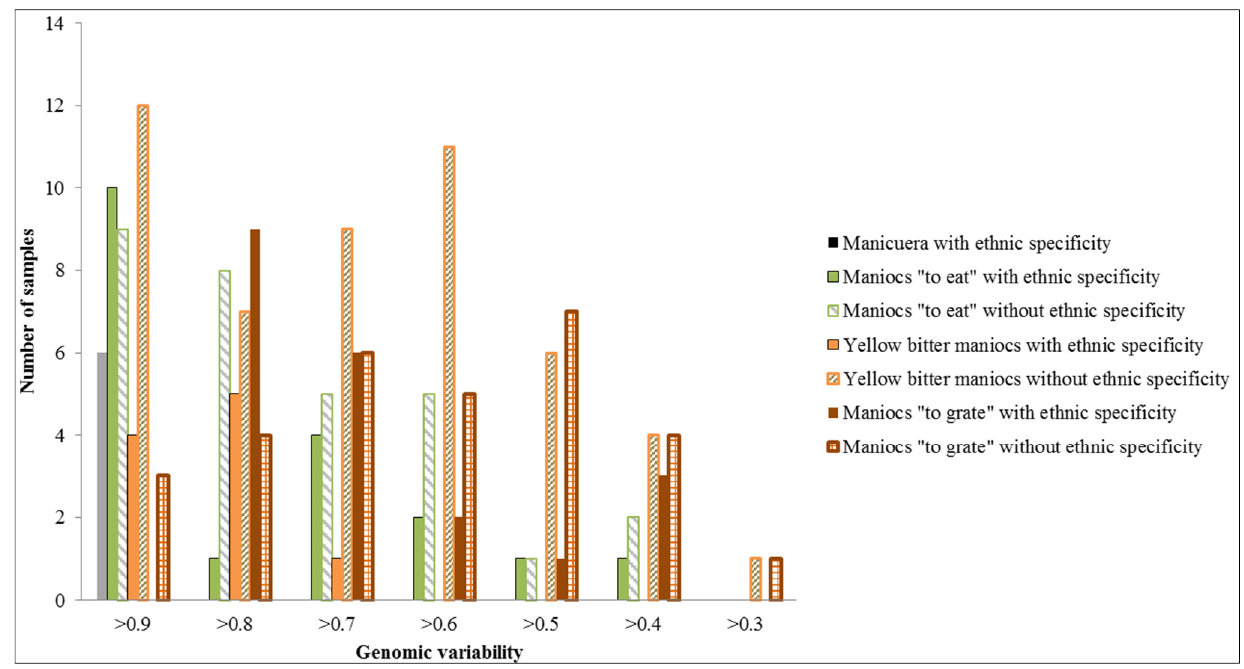
Figure 3. Genomic variability as expressed by the single population membership